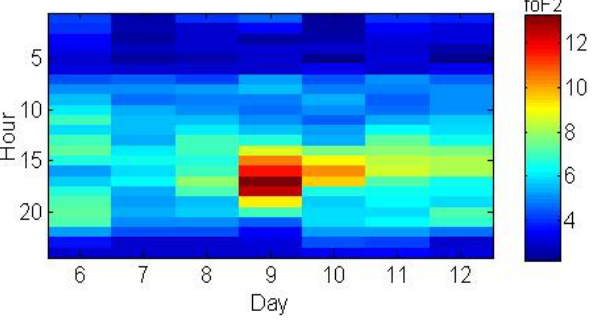
Fig.1. Variations of foF2 from May 6 to 12 over Chongqing station